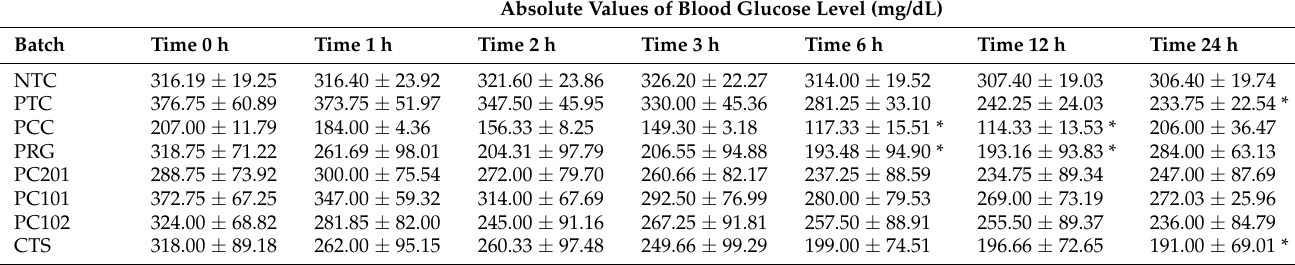
Table 3. Absolute values of the blood glucose level over a period of 24 h following a single-dose administration of the various formulations.